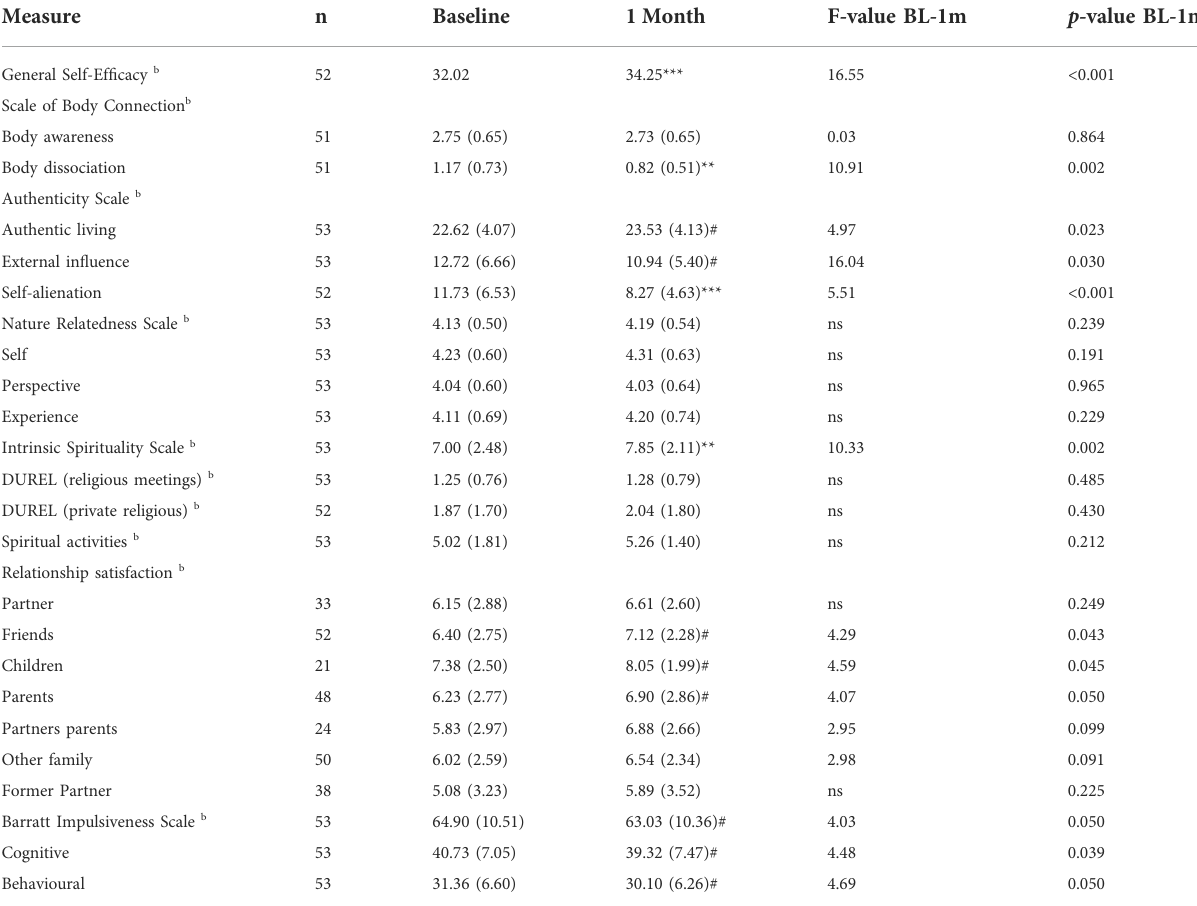
TABLE 2 Secondary outcomes repeated measures at baseline, day seven (where available), and 1 month. Values are given as means (standard deviations in brackets).